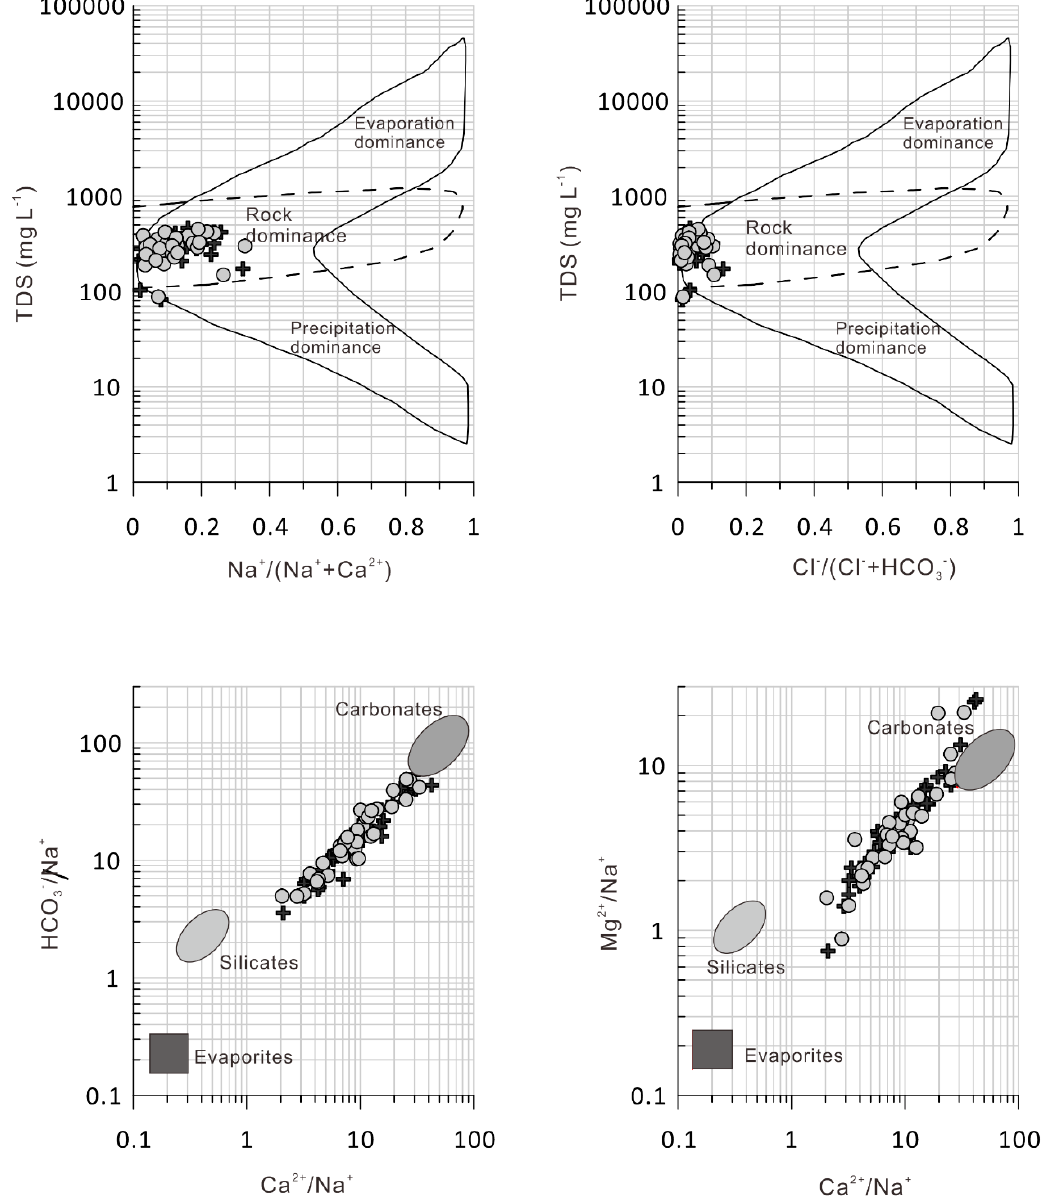
Figure 3. Gibbs and mixing diagrams for the water samples from the upper reaches of Syr Darya River and its tributaries, Aral Sea Basin. The grey dots represent the water samples collected during the low-flow season (LFS) and the black crosses are those collected during the high-flow season (HFS). Almost all water samples fall in the calcium bicarbonate array (Figure 4). During the LFS, only three samples fall in the not dominant category of the lower parts of the ternary